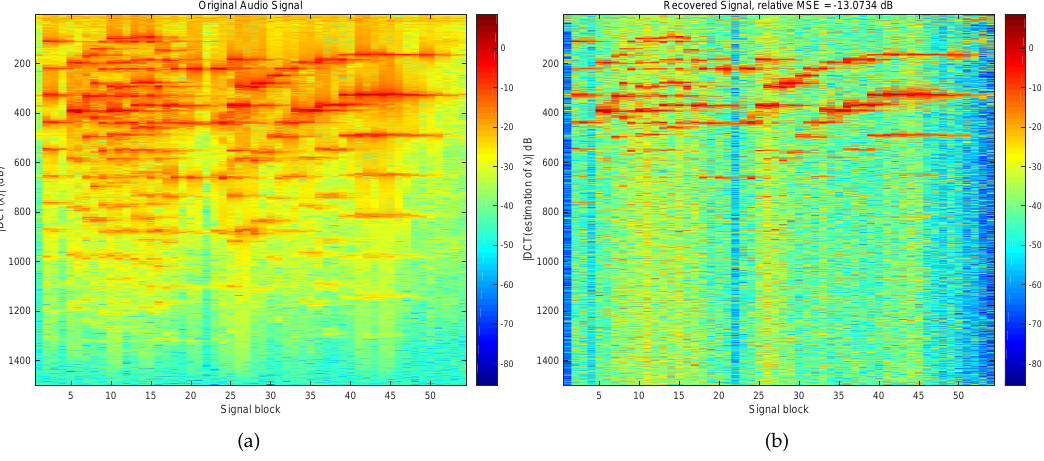
Figure 3. Recover the audio signal by Bernoulli Gaussian Pursuit GAMP. ( a ) Spectra of the original signal; ( b ) Spectra of the recovered signal, major signal energy has been restored but lost some